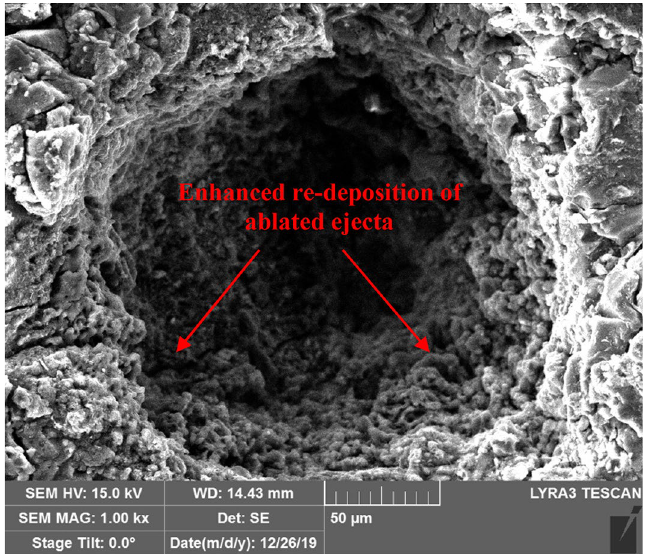
Figure 10. Focused ion beam scanning electron microscopy (FIB-SEM) image of the interior part of coal crater ablated by fs-Solstice system (a train pulse of 100 signals). The re-deposited ablated ejecta inside the crater resemble those formed on the surface as nanoparticle-sized which confirms the enhanced thermal energy deposition for fs-LA.